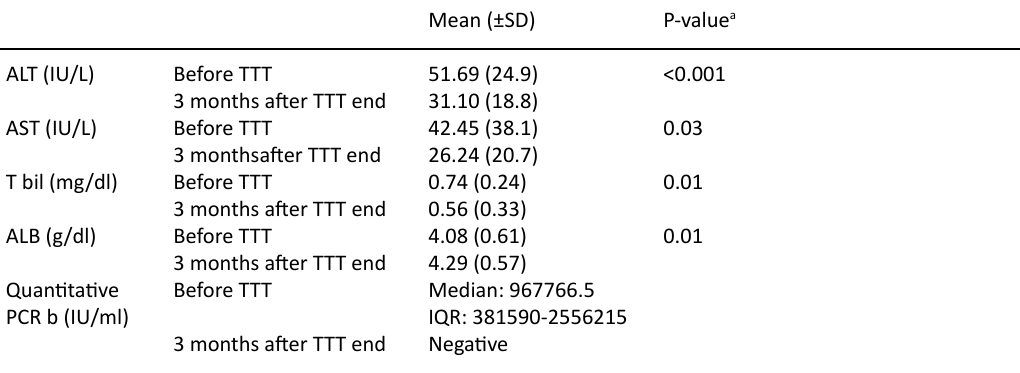
Table 1. Patients laboratory investigations done before treatment and 3 months after treatment end